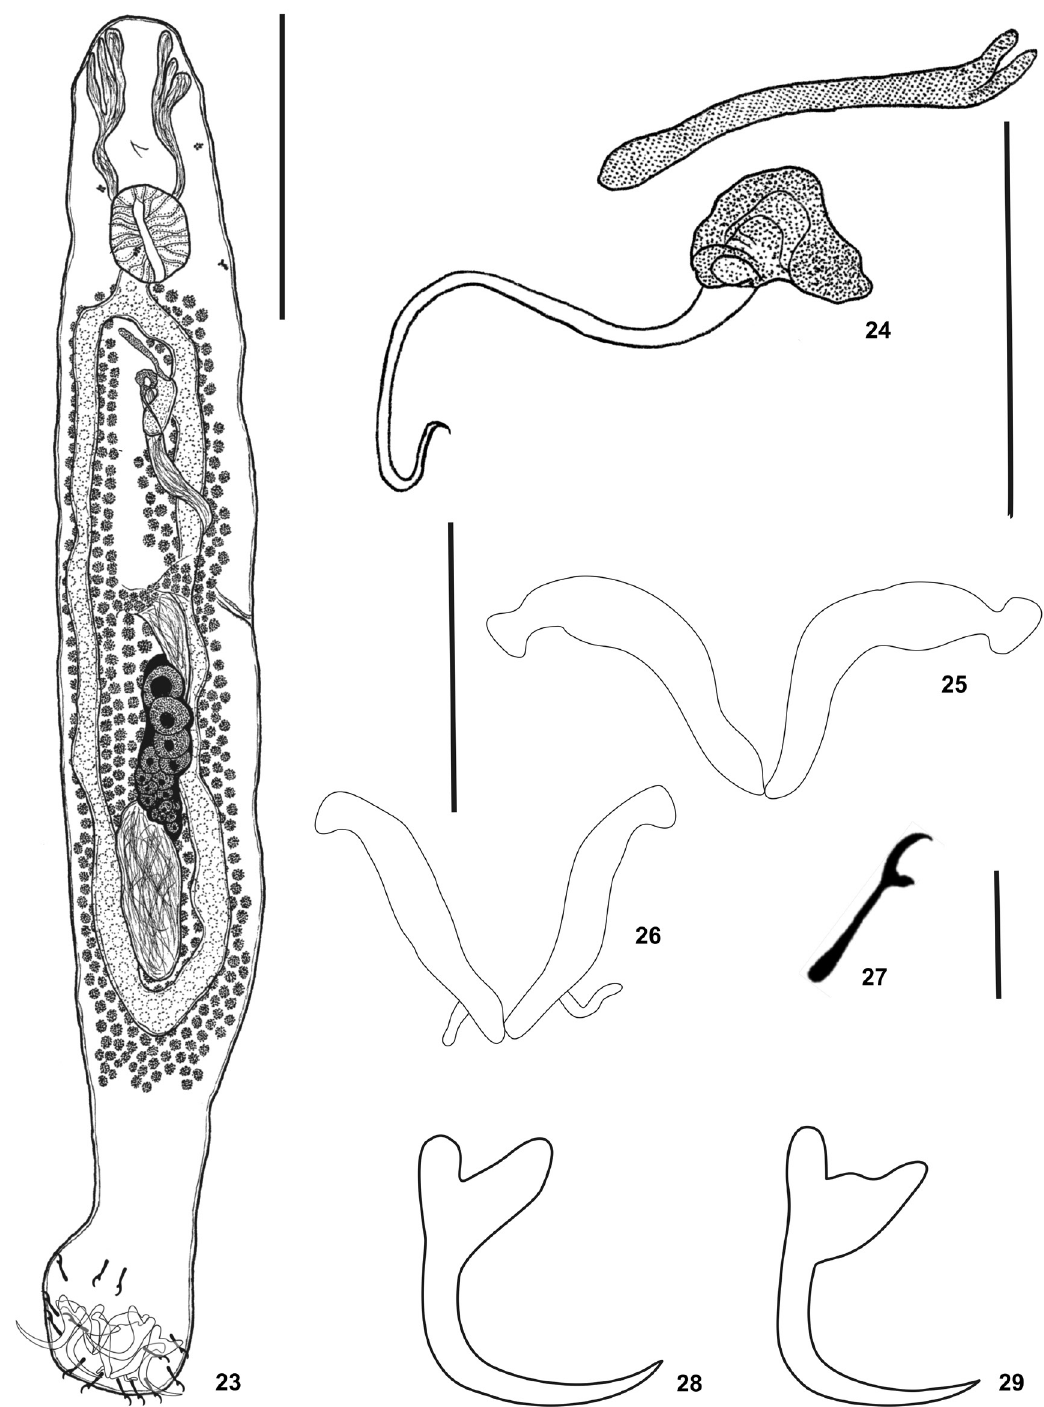
Figures 23–29. Cosmetocleithrum bifurcum Mendoza-Franco, Mendoza-Palmero & Scholz, 2016: (23) voucher whole-mount, ventral; (24) copulatory complex; (25) ventral bar; (26) dorsal bar; (27) hook; (28) ventral anchor; (29) dorsal anchor. Scale bars: 23 = 100 μm; 24–26, 28, 29 = 25 μm; 27 = 10